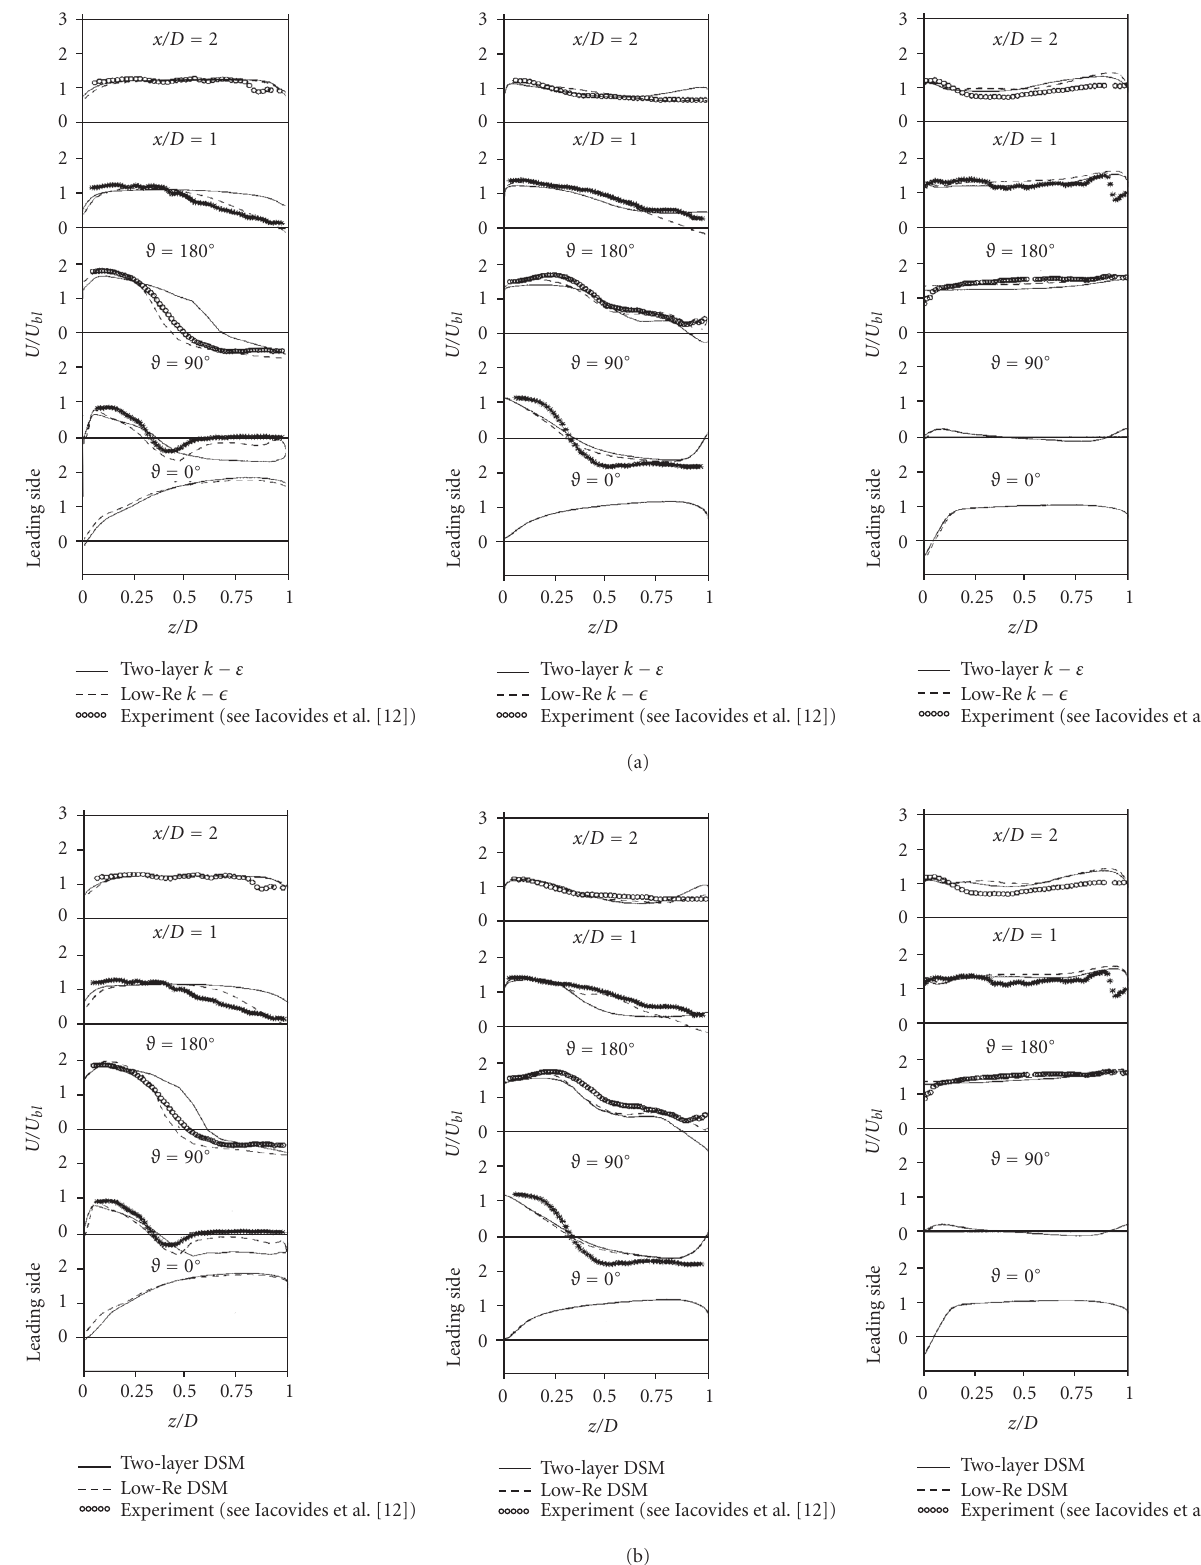
Figure 5: Comparisons between (a) predicted and (b) measured profiles of mean streamwise velocity. The left plot indicates inner plane C, the middle plot indicates mid-plane B, and the right plot indicates outer plane